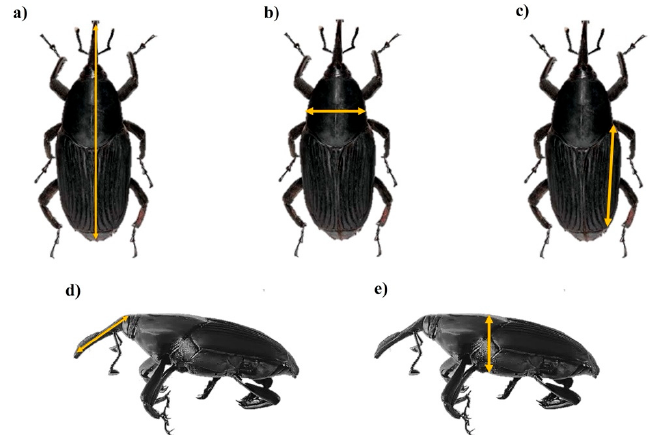
Figure 3. Images of the Rhynchophorus palmarum male showing morphometric trait measurements taken for ( a ) body length, ( b ) pronotum width, ( c ) elytron length, ( d ) rostrum length, and ( e ) meso- thorax